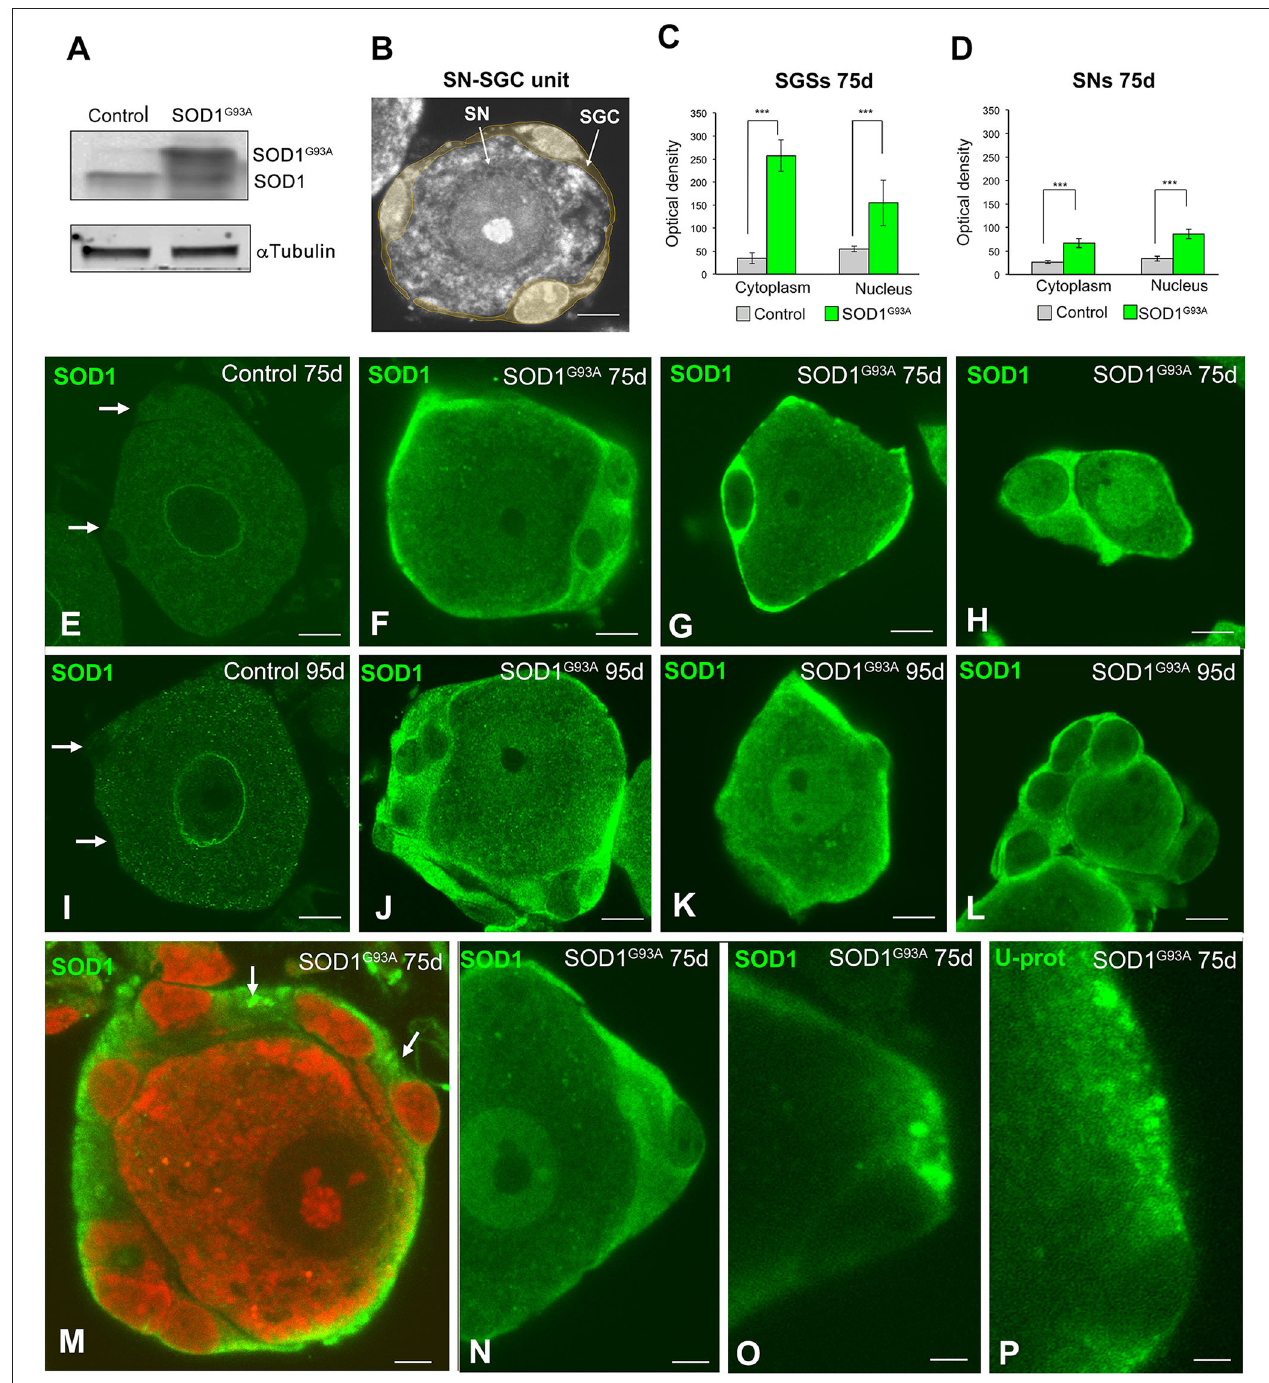
FIGURE 2 | Expression of SOD1 in SN-SGC units from control and SOD1 G93 mice. (A) Western blotting of SOD1 expression in DRG lysates from control and SOD1 G93A mice. Note the high levels of SOD1 G93A expression found in SOD1 transgenic mice. α -tubulin was used as load control. (B) Representative example of a typical SN-SGC unit in a control DRG. GSCs appear colored in pale yellow. (C,D) Densitometric analysis of SOD1 expression in the nucleus and cytoplasm of SGCs and sensory neurons at 75 and 95 days of age. (E–L) Immunodetection of SOD1 in control and SOD1 G93 SN-SGC functional units at 75 (E–H) and 95 (I–L) days of age. (E,I) Images of control SN-SGC units showing low levels of SOD1 expression in the nucleus and cytoplasm from both sensory neuron and SGCs (arrows). (F–H,G–L) Representative examples of types (A–C) SN-SGC units from SOD1 G93A at 75 and 95 days of age. Note the high levels of cytoplasmic SOD1 in SGCs and the moderate expression of SOD1 in sensory neurons. (M) A SN-SGC unit of a SOD1 G93 mouse immunolabeled for SOD1 and counterstained with PI illustrating the